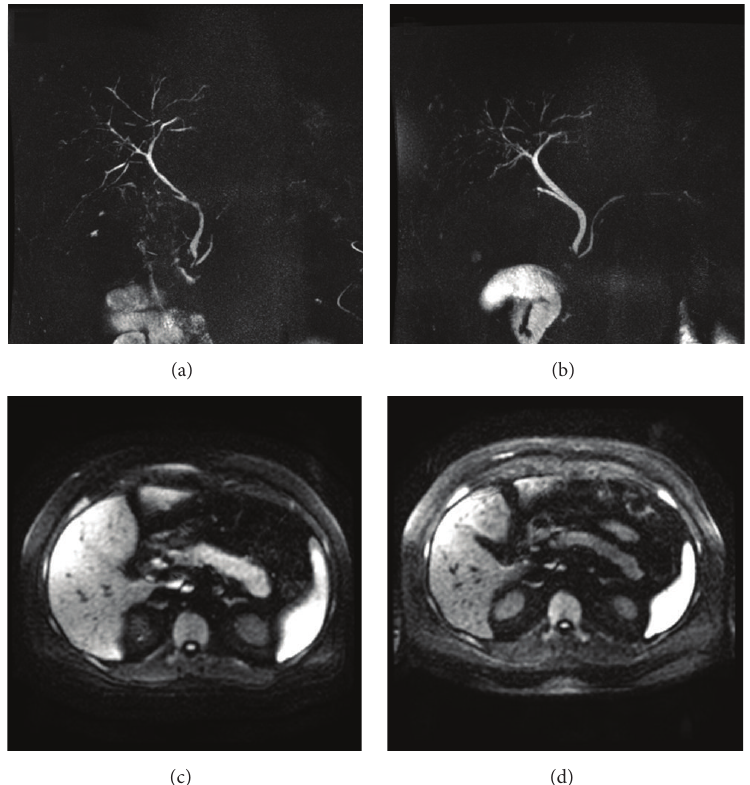
Figure 2: MRCP findings: Case 2 . (a) Extrahepatic bile duct narrowing. (b) Resolution after steroid therapy. (c) Diffusion restriction shows hyperintensity and edema in the pancreatic tail. (d) Resolution after steroid therapy. 157, amylase of 82, CA of 19-9 194, CEA of 2.9, total IgG